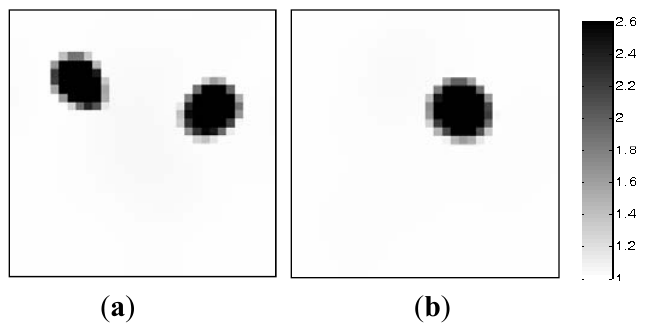
Figure 11. Reconstructed images by the MMVDR algorithm under the noise level of 24%.